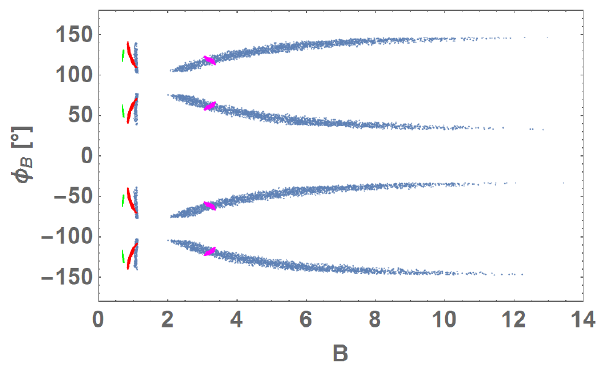
Figure 3 . Predictions for case III, where the red lines for sin 2 (cid:18) 23 and (cid:14) CP denote the experimental bounds of 3 (cid:27) (global analyses) and 2 (cid:27) (T2K) ranges, respectively: (a) (cid:14) CP versus sin 2 (cid:18) 23 and (b) (cid:14) CP versus k .